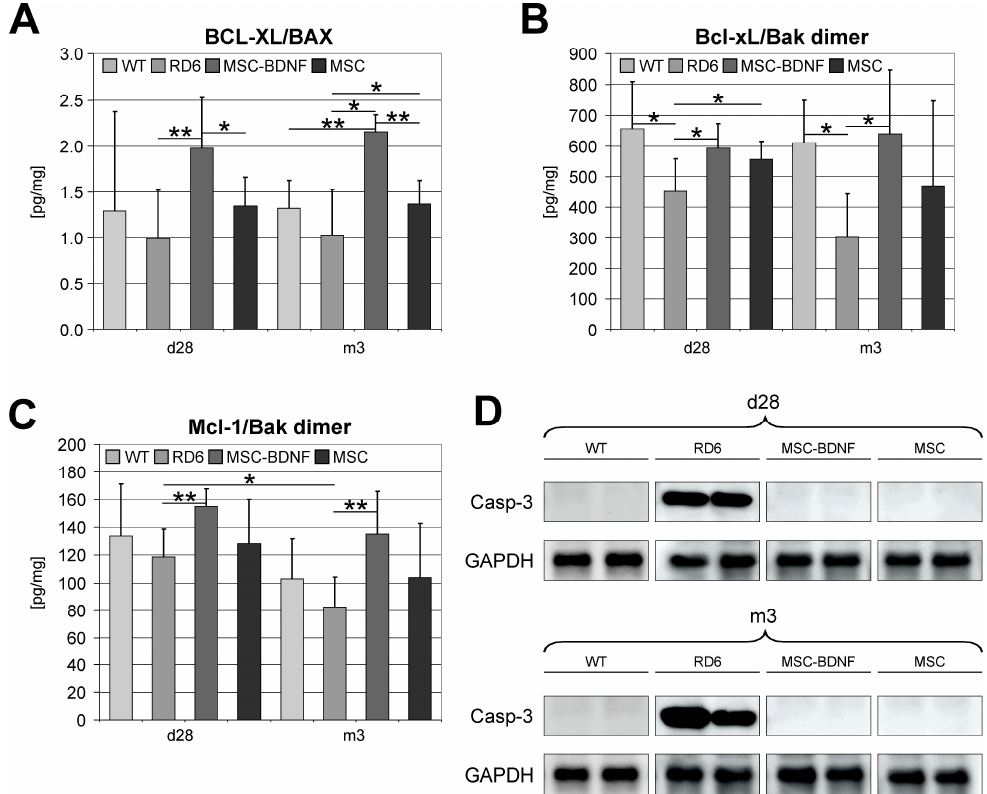
Figure 4. The expression profile of selected apoptosis-related molecules in retinas treated with MSC-BDNF or MSC alone at different time points (at 28 days and three months post transplantation) and compared to WT and rd6 mice. The mRNA expression of Bcl-xL and BAX genes was determined by the quantitative PCR and the relative ratio Bcl-xL/BAX was calculated ( A ). The concentration of Bcl-xL and Bak protein dimer was determined by specific Luminex ( B ) Similarly, the concentration of Mcl-1/Bak dimer protein was measured ( C ). Caspase-3 protein expression was determined by Western blot, which revealed a lack of expression of this form in WT mice and rd6 after cell transplantation compared to rd6 mice with no treatment ( D ). GAPDH served as loading. A representative image is shown. Mean values ± SDs are presented in the diagrams, * p < 0.05, ** p < 0.01 ( n = 7/group/time point).